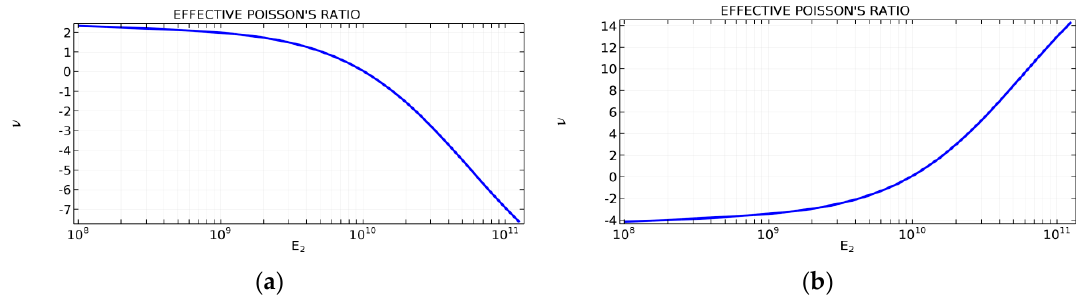
Figure 2. Values of the effective Poisson’s ratio (PR) for different values of E 2 of tunable two-phase ( a ) honeycomb; and ( b ) re-entrant honeycomb composite structures.